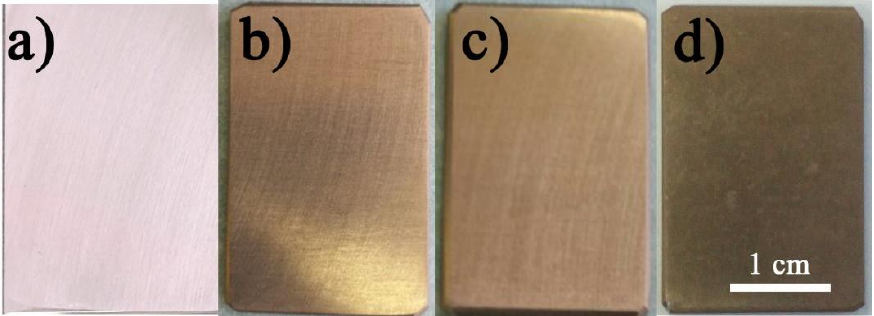
Figure 2. Digital photos of ( a ) bare Mg alloy; ( b ) NiAl-LDH/CT; ( c ) NiAl-LDH/NT; and ( d ) NiAl-LDH/ST coatings.